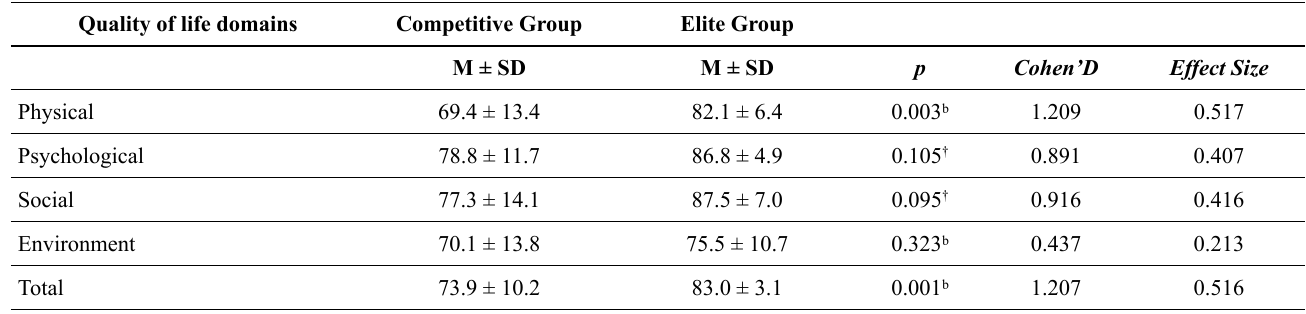
Table 4. WHOQOL-Bref’s quality of life domains according to the competitive level Quality of life